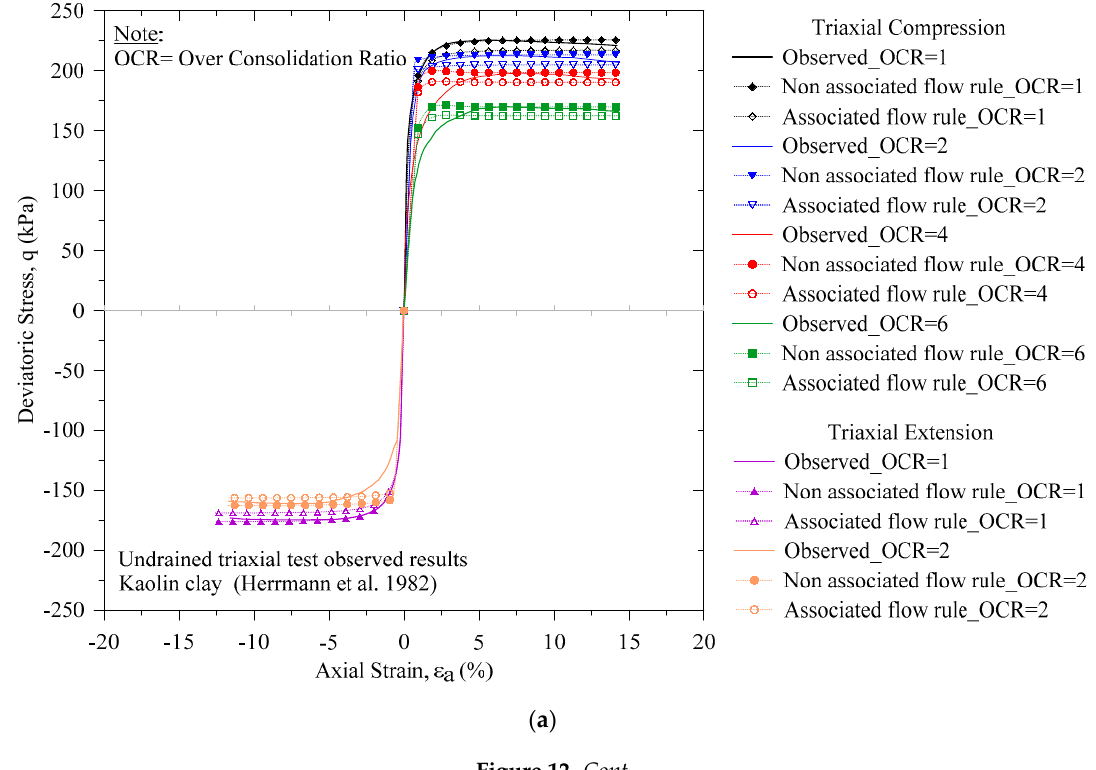
Figure 11. Comparison of the measured and the predicted consolidated drained triaxial compression tests on the San Francisco Bay Mud clay: ( a ) the deviatoric stress vs. the axial strain and ( b ) the volumetric strain vs. the axial